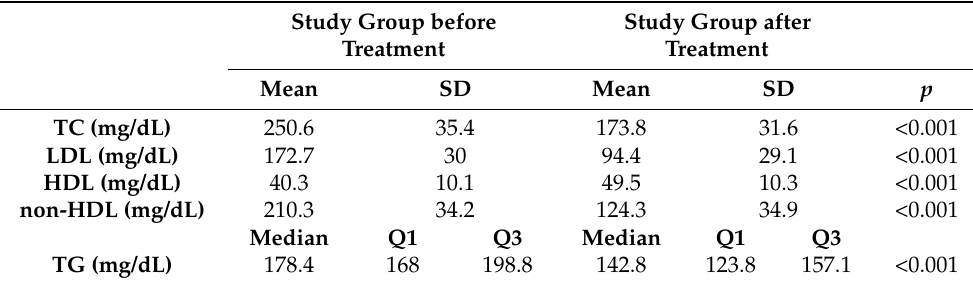
Table 3. Effect of proprotein convertase subtilisin/kexin type 9 (PCSK-9) inhibitors on plasma lipids. TC—total cholesterol; LDL—low-density lipoprotein cholesterol; HDL—high-density lipoprotein